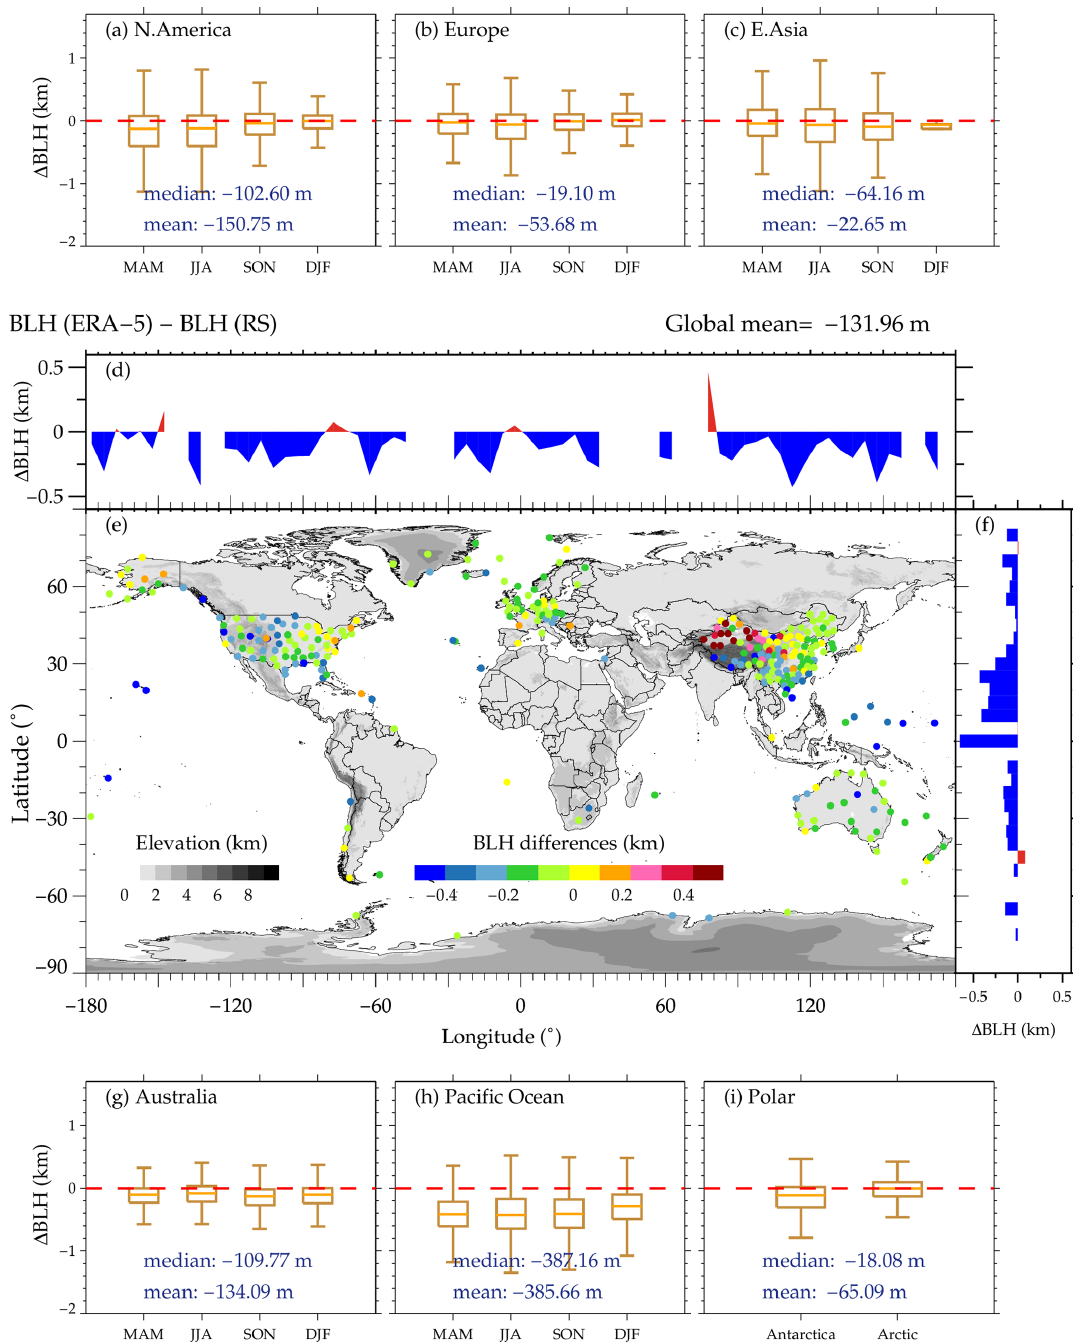
Figure 7. Statistical results of BLH differences between ERA5 and radiosonde. The spatial distribution of mean differences is highlighted in (e) . Also shown are the distributions of mean BLH differences as a function of longitude (d) and latitude (f) . The box and whisker plot of BLH differences over the six regions of interest (i.e., North America, Europe, East Asia, Australia, Pacific Ocean, polar regions) over four seasons are displayed in (a–c) and (g–i) . The seasons are defined as follows: MAM, March–April–May; JJA, June–July–August;